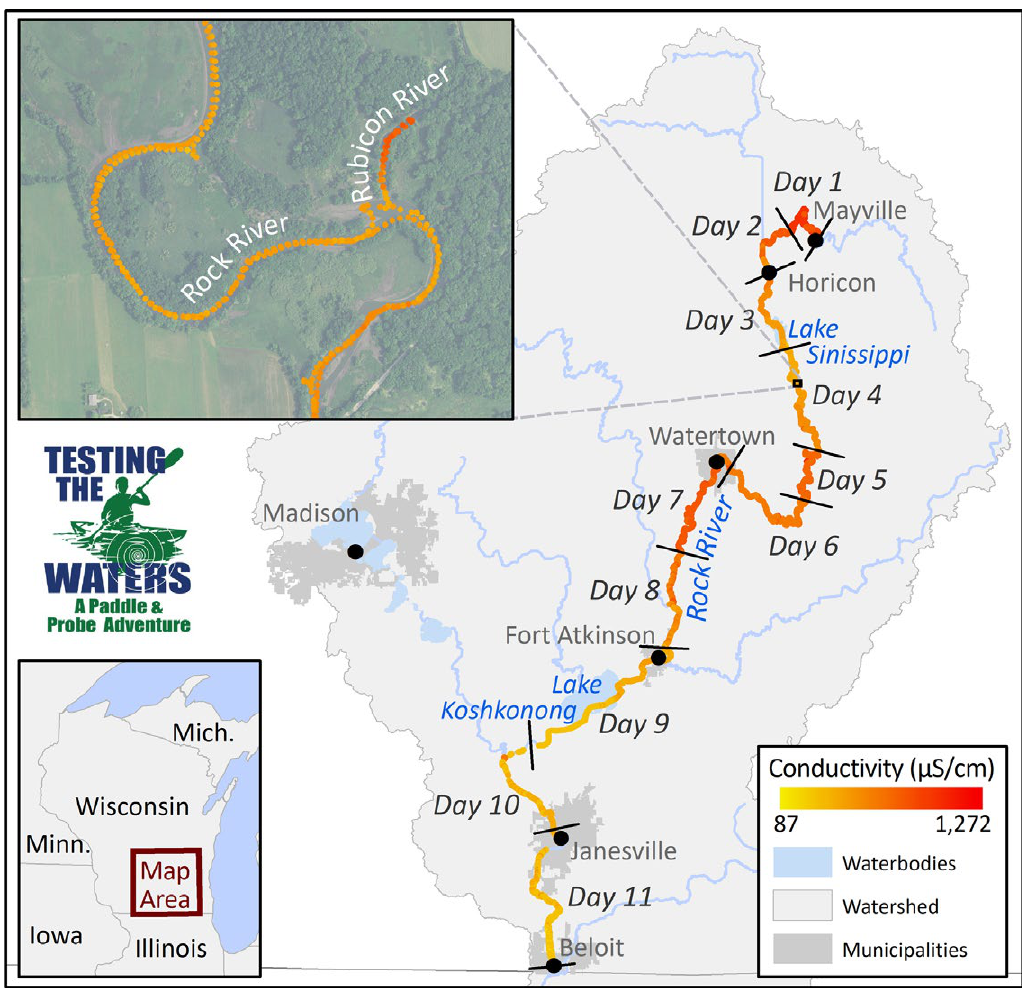
Figure 7: Map showing study area and point sample data for conductivity ( µ S/cm) for the Testing the Waters event on the Rock River, Wisconsin, with inset showing individual sample from both sampling craft. Sources: ESRI 2014, WisconsinView